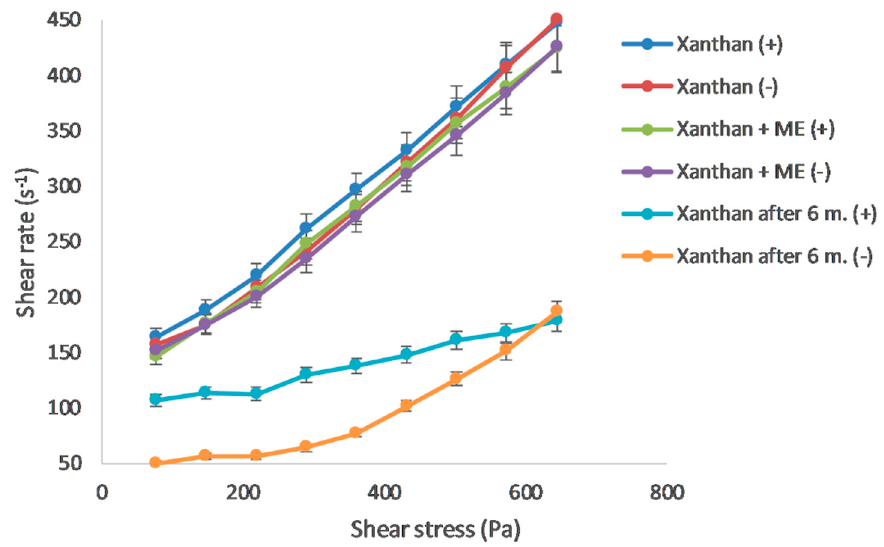
Figure 2. Rheogram for Carbopol gel, ME-containing Carbopol gel, and Carbopol gel after 6 months; (+) up-curve, ( − ) down-curve.